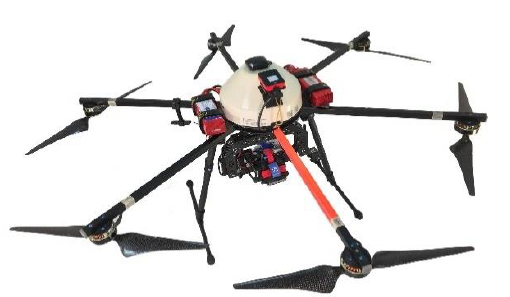
Figure 1. The HEXA-PRO UAV used for the survey equipped with the Parrot Sequoia camera